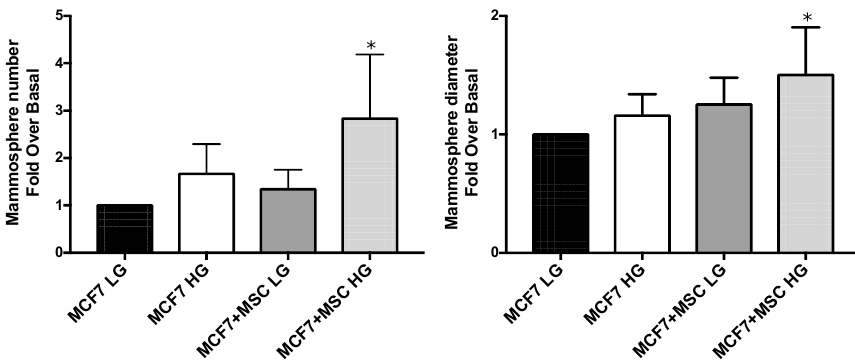
Figure 6. Effect of glucose and MAT-MSCs on mammosphere formation. Three-dimensional cul- tures were set up by using MCF7 and MAT-MSCs (ratio 4:1) in LG or HG concentrations. After 10 days, mammosphere number and diameter were obtained. Results were reported as fold over basal (MCF7 LG). Bars represent mean ± SD of 4–5 independent experiments showing mammosphere number and diameter in BC cells, co-cultured and not with MAT-MSCs. Data were analyzed using the non-parametric Friedman test followed by Dunn’s correction for multiple comparisons. * denotes statistically significant values compared with MCF7 LG (* adjp < 0.05). Notably, when disaggregated, MCF7 included in spheroids with MAT-MSCs in HG displayed a 4.3-fold increase in OCT44 protein (adjp < 0.05) with no change of NANOG levels (Figure 7a, Supplementary Figure S7a). In parallel, in the same spheroids, a signifi- cant increase in α -SMA (adjp < 0.05), FAP (adjp < 0.01) and p16 INK4a (adjp < 0.05) proteins was observed in MAT-MSCs (Figure 7b, Supplementary Figure S7b). In addition, in these cells NANOG protein levels did not change. However, a 50% significant reduction of OCT4 (adjp < 0.05) was detected (Figure 7b, Supplementary Figure S7b).